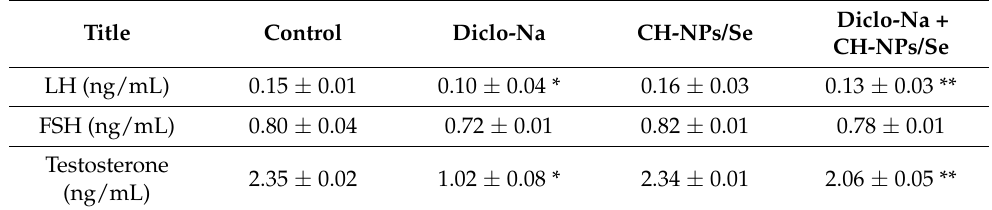
Table 2. Effect of CH-NPs/Se on serum reproductive hormones in male rats treated with Diclo-Na.